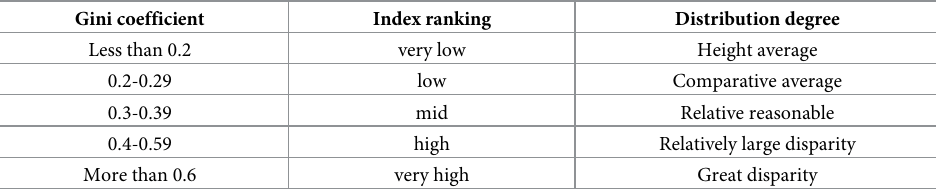
Table 5. Gini coefficient level established by the United Nations Development